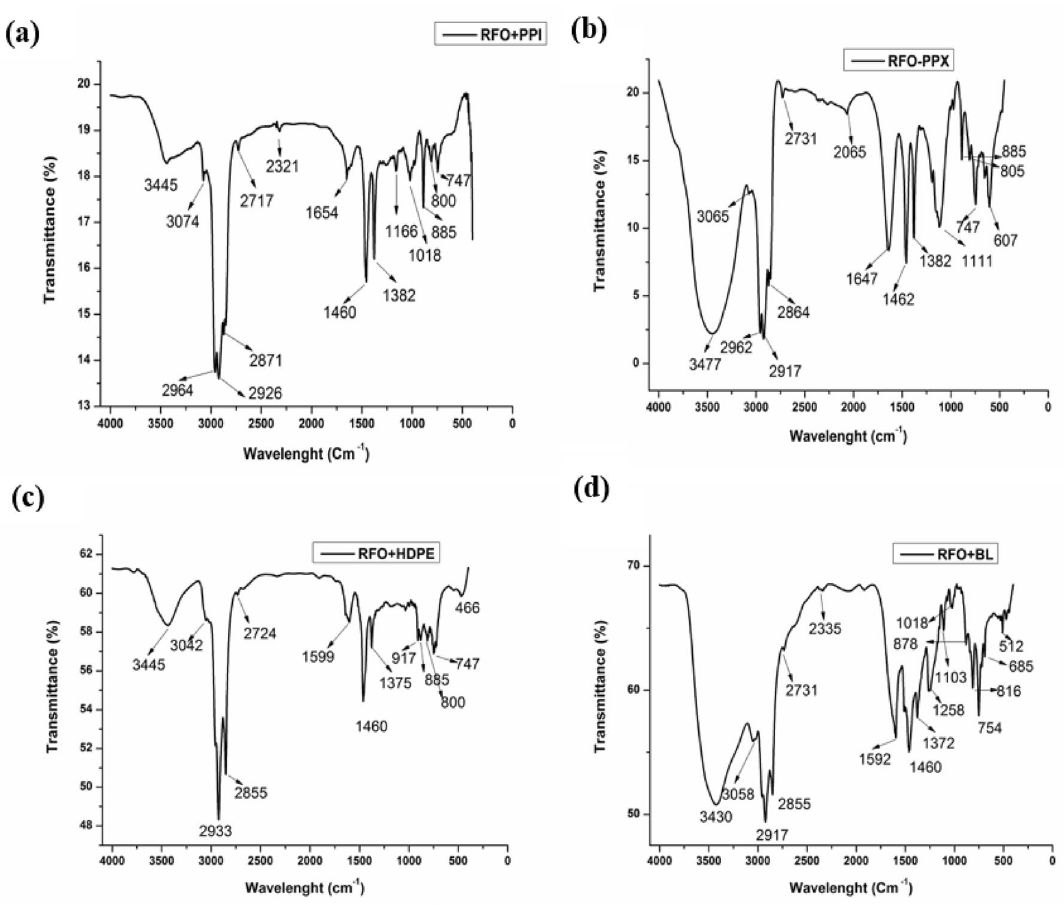
Figure 3. FT-IR spectra of the liquid product obtained from the co-cracking of ( a ) RFO + PPI ( b ) RFO + PPX ( c ) RFO + HDPE ( d ) RFO +